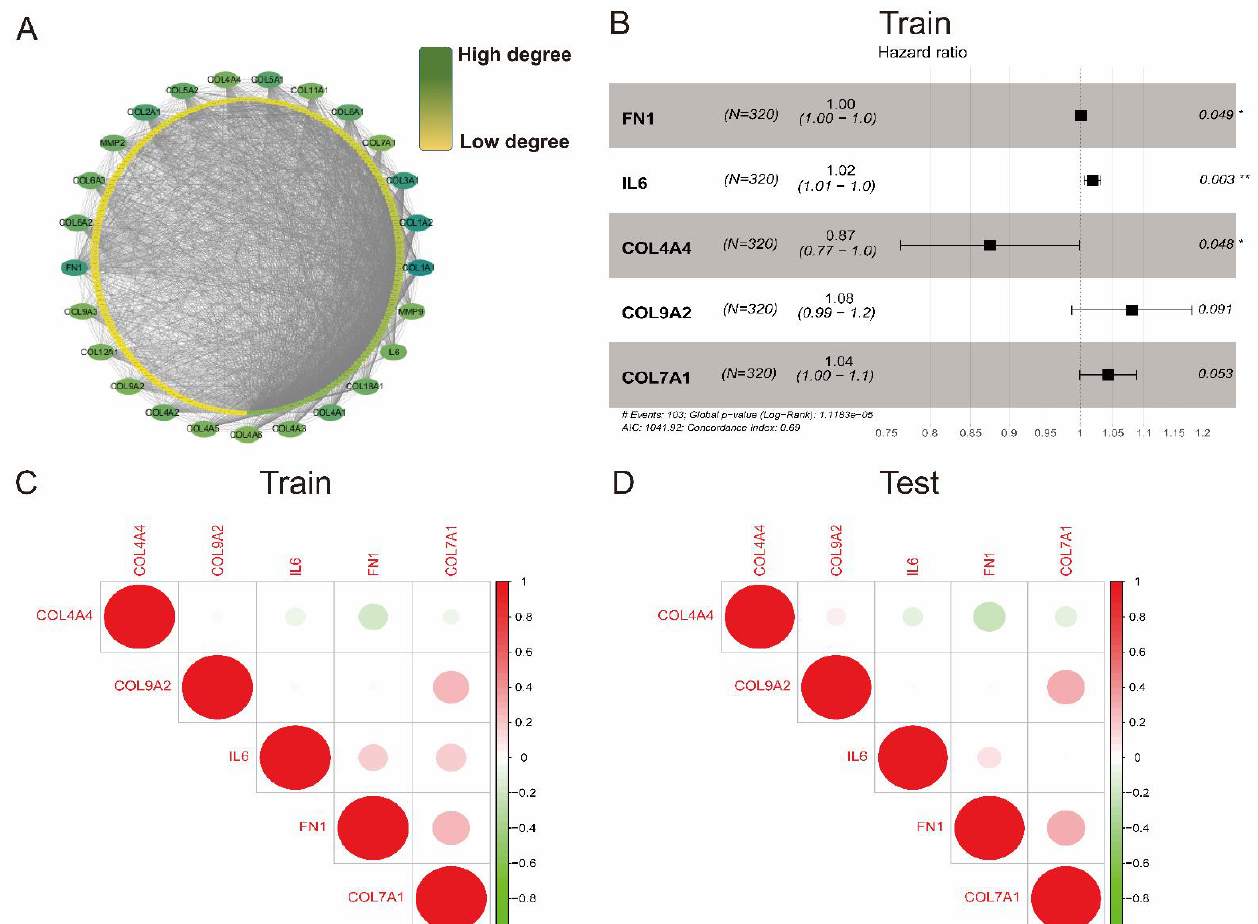
Figure 1. Identification of collagen-related signature to predict prognosis of ccRCC. ( A ) 25 hub genes dragged out from 257 collagen-related genes based on interaction degrees; ( B ) Establishment of a collagen-related risk model by univariate and multivariate cox regression; ( C , D ) Spearman correlation analysis of five collagen-related genes in train and test cohort. * p < 0.05, ** p < 0.01.